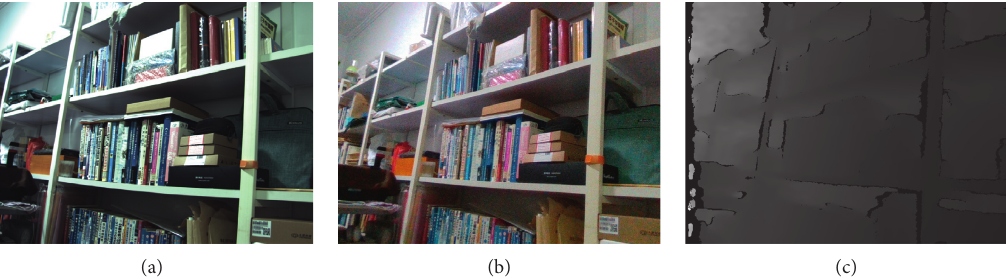
Figure 4: Examples of images captured by the camera group. (a) Industrial camera RGB image. (b) Depth camera RGB image. (c) Depth map of the depth camera.